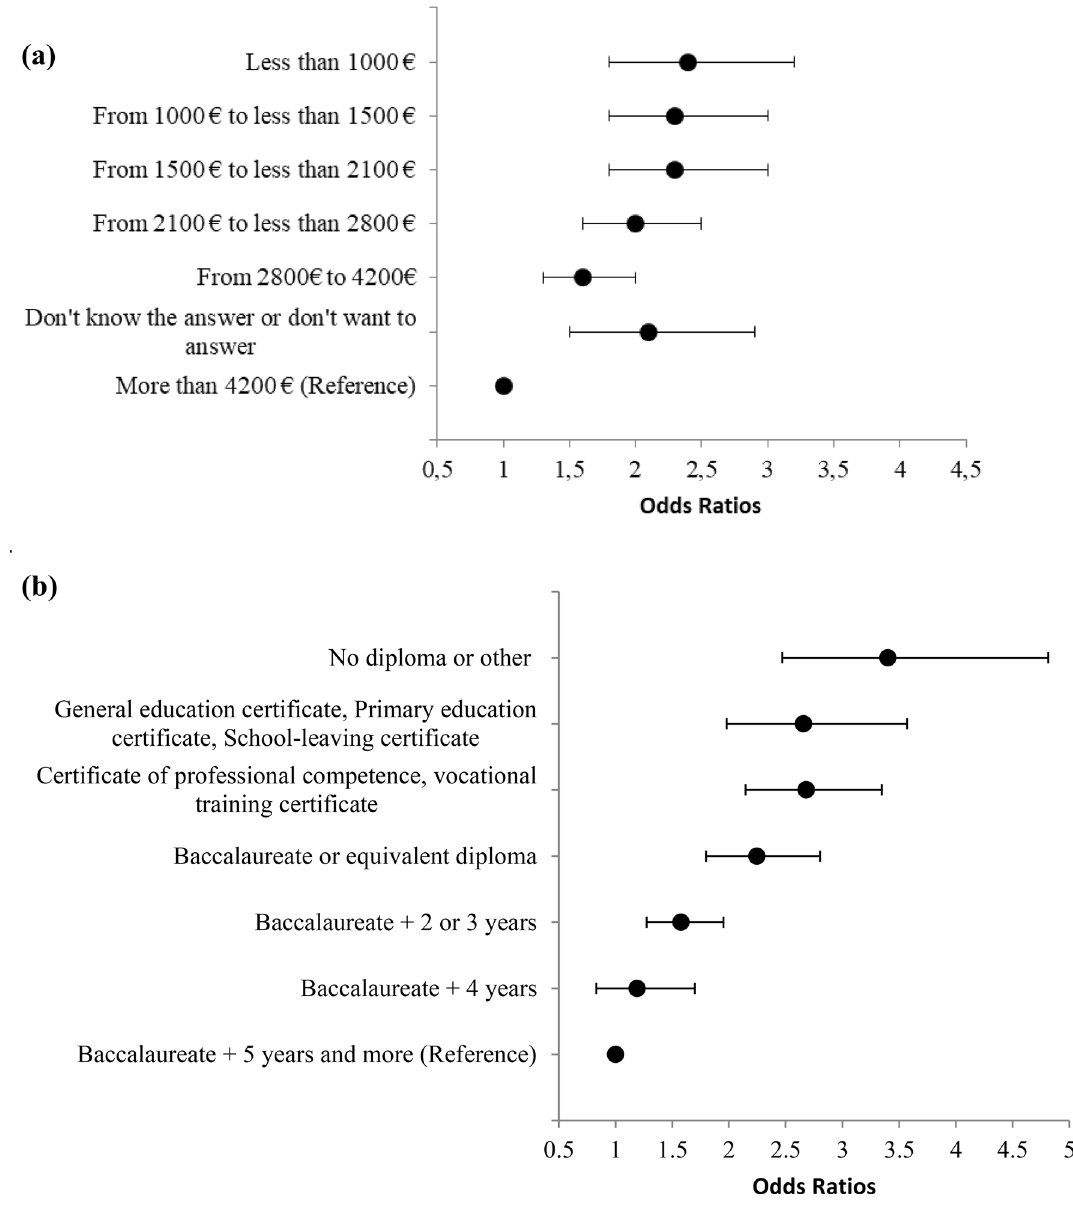
Figure 4. ( a ) ORs and 95% of obesity by income categories using multivariate logistic regression with weighted and age and sex-adjusted estimates in survey year 2016. Model adjusted for age, sex, smoking and physical activity level. Interaction of survey year was tested with each characteristic in the model and was not significant. Linear trend across income characteristic is significant (p < 0.0001). Age and sex-adjusted by the raking ratio method using the Insee data and age groups 18–29, 30–39, 40–49, 50–59, and 60–69 years. ( b ) ORs and 95% of obesity by education categories using multivariate logistic regression with weighted and age and sex-adjusted estimates in survey year 2016. Model adjusted for age, sex, smoking and physical activity level. Interaction of survey year was tested with each characteristic in the model and was not significant. Linear trend across education characteristic is significant (p < 0.0001). Age and sex-adjusted by the raking ratio method using the Insee data and age groups 18–29, 30–39, 40–49, 50–59, and 60–69